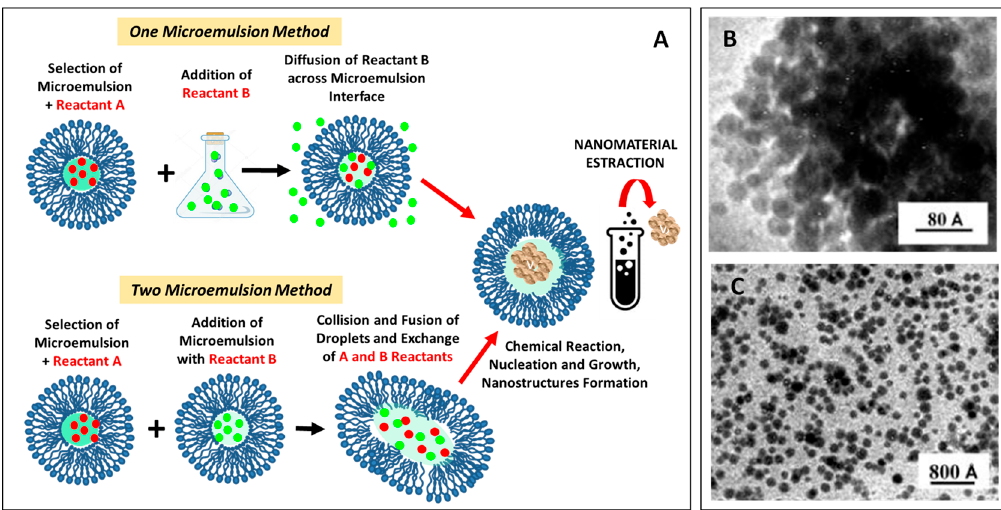
Figure 7. Sketch of the main approaches employed for the synthesis of nanoparticles with the One and Two Microemulsion methods ( A ). Transmission electron microscopy (TEM) image of the surfactant coated Na 2 S ( B ) and ZnSO 4 ( C ) nanoparticles produced by using a Water/AOT/n-Heptane, W/O microemulsion [61].